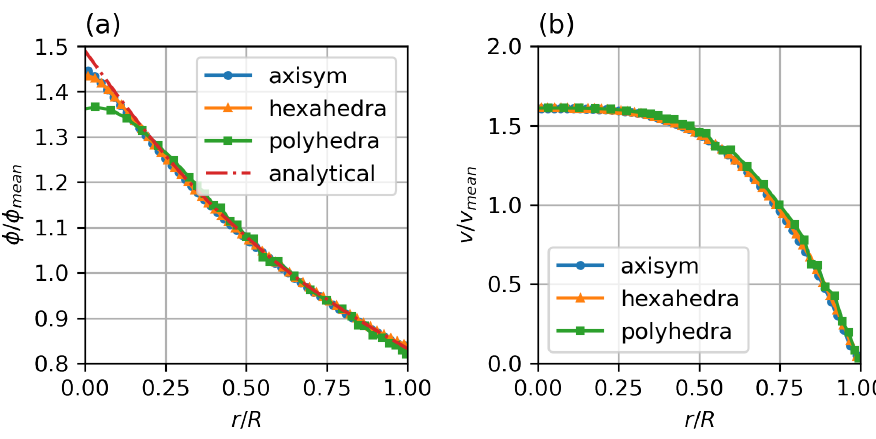
Figure 4. Steady state particle distribution ( a ) and velocity profiles ( b ) for different mesh types, compared with analytical solution for particle distribution by Krieger et al. Parameters: fully developed pipe flow, R = 50 µ m, V = 0.0065 m s − 1 , K c = 0.41, K µ = 0.62, n = 1.82, φ ∗ = 0.68, Standard Krieger–Dougherty